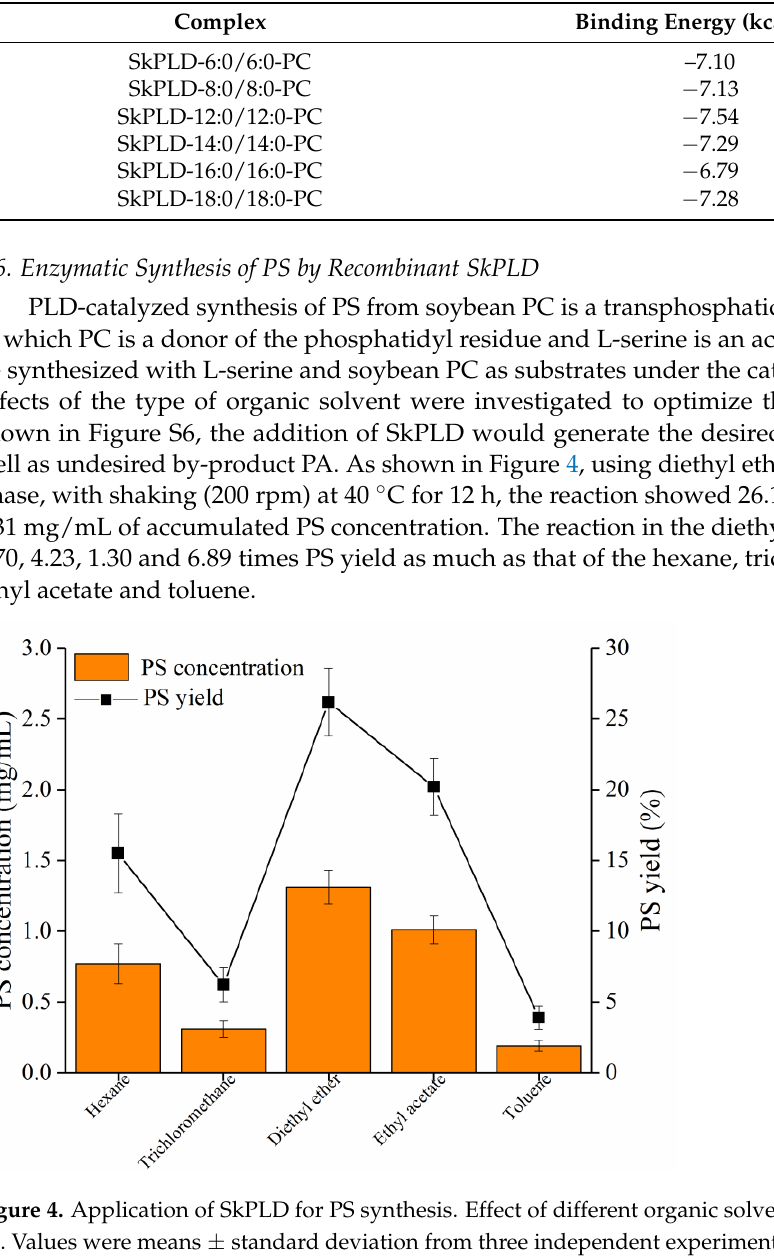
Table 2. The estimated binding energy of SkPLD-PC complexes.